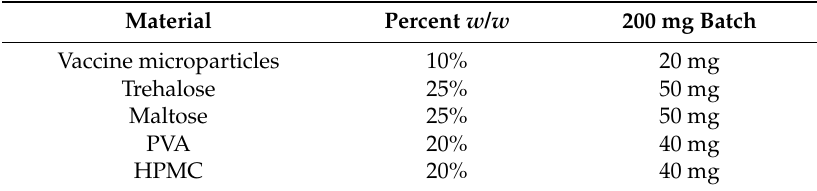
Table 1. Formula for the preparation of